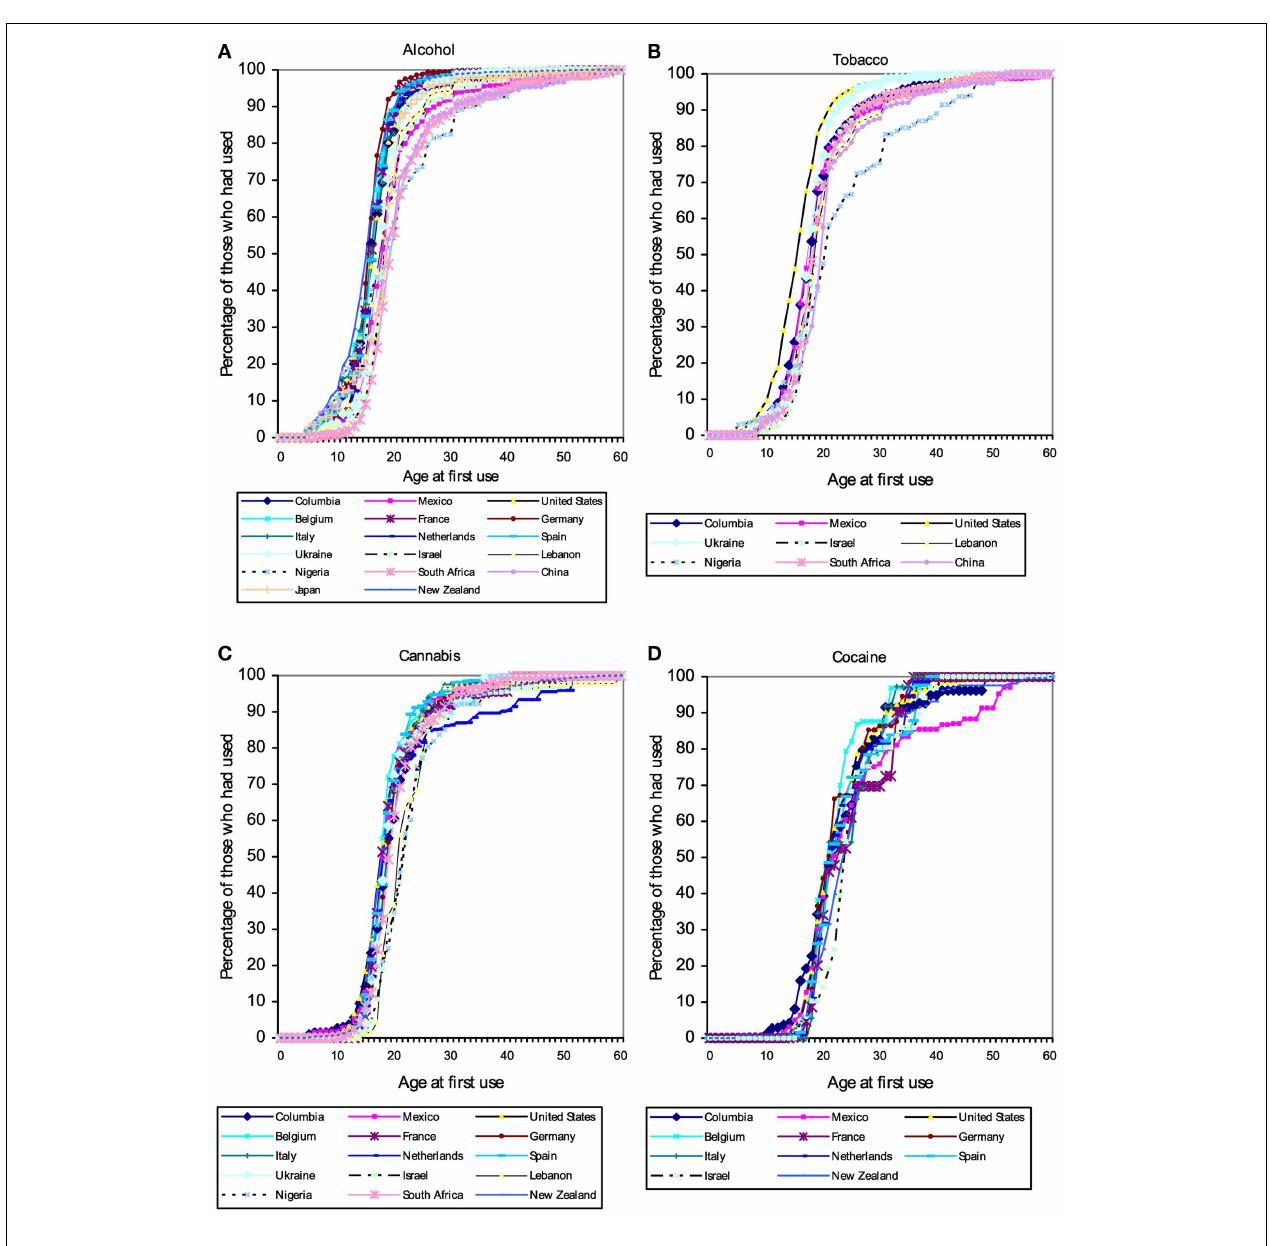
Health Survey Initiative.These patterns suggest the existence of a developmental “switch” that flips during adolescence. Figures from Ref.